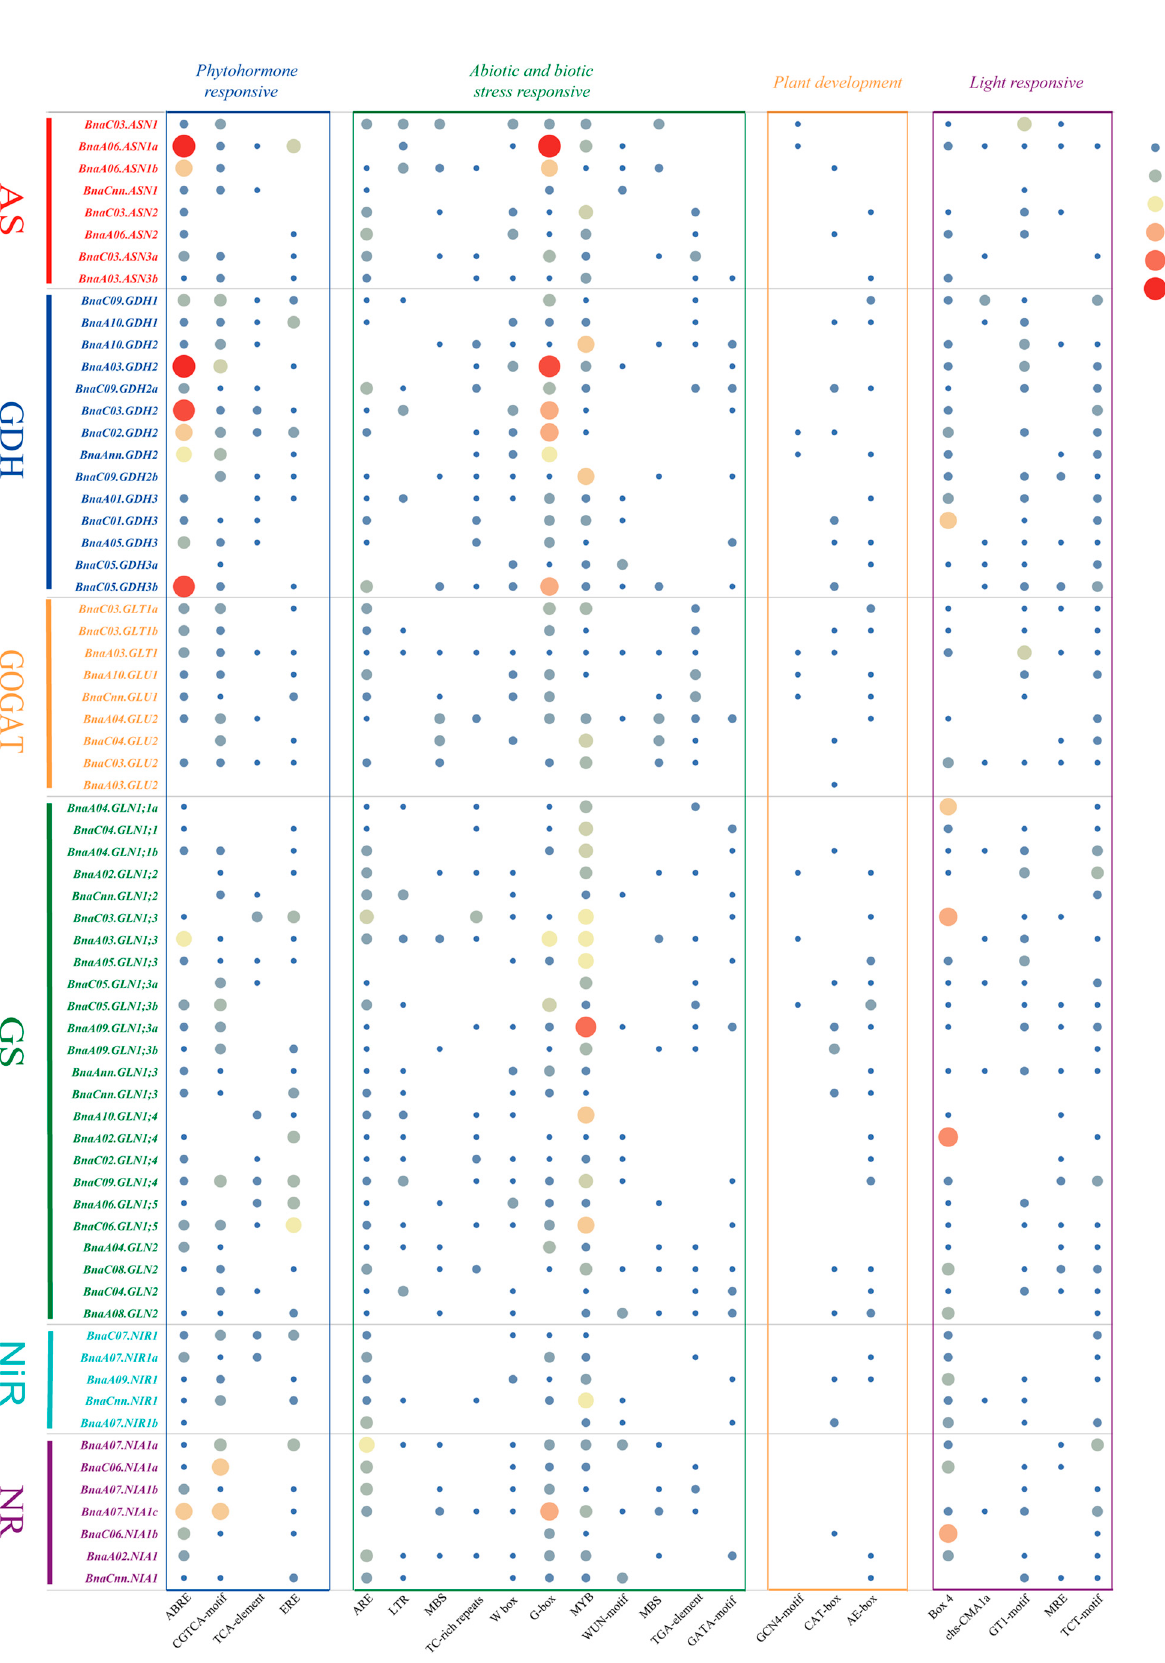
Figure 5. The cis-acting regulatory elements in the promoter regions of the rapeseed nitrogen assimilation-related genes. The blue, green, orange and purple blocks represent phytohormone, abiotic and biotic stress, plant development, and light response cis-elements, respectively. The number of cis-elements is indicated by different colors and circle size.